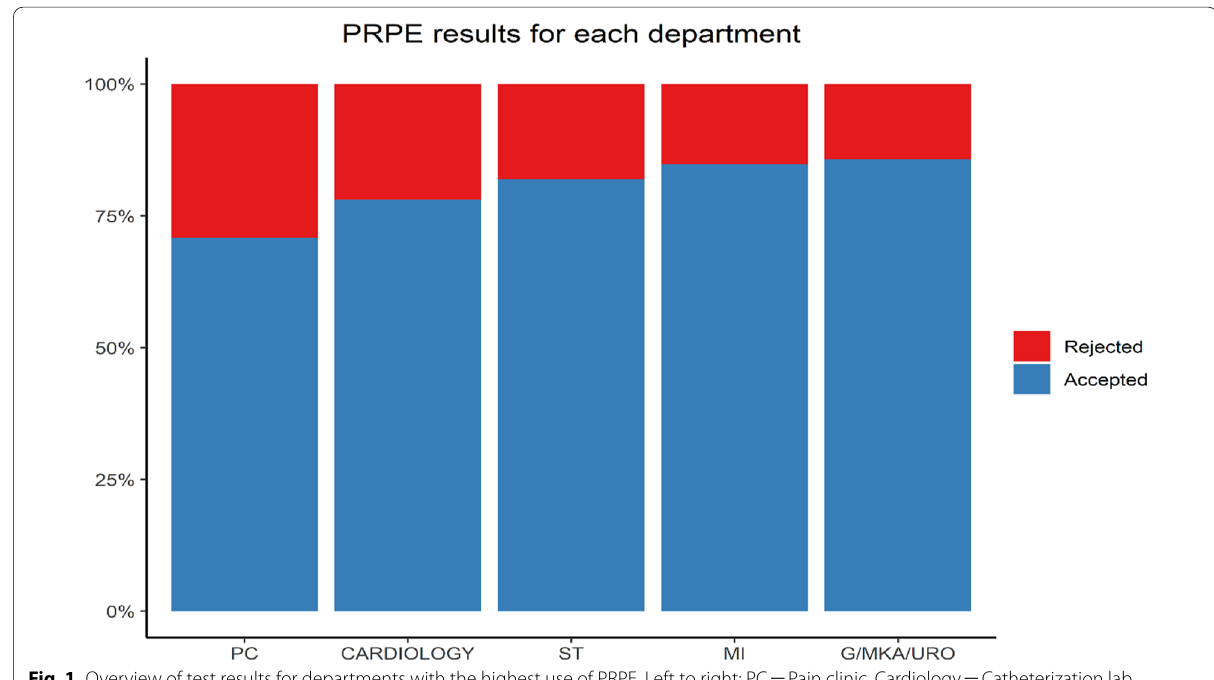
Fig. 1 Overview of test results for departments with the highest use of PRPE. Left to right: PC ST Surgery theatre, MI Medical Imaging, G/MKA/URO = =